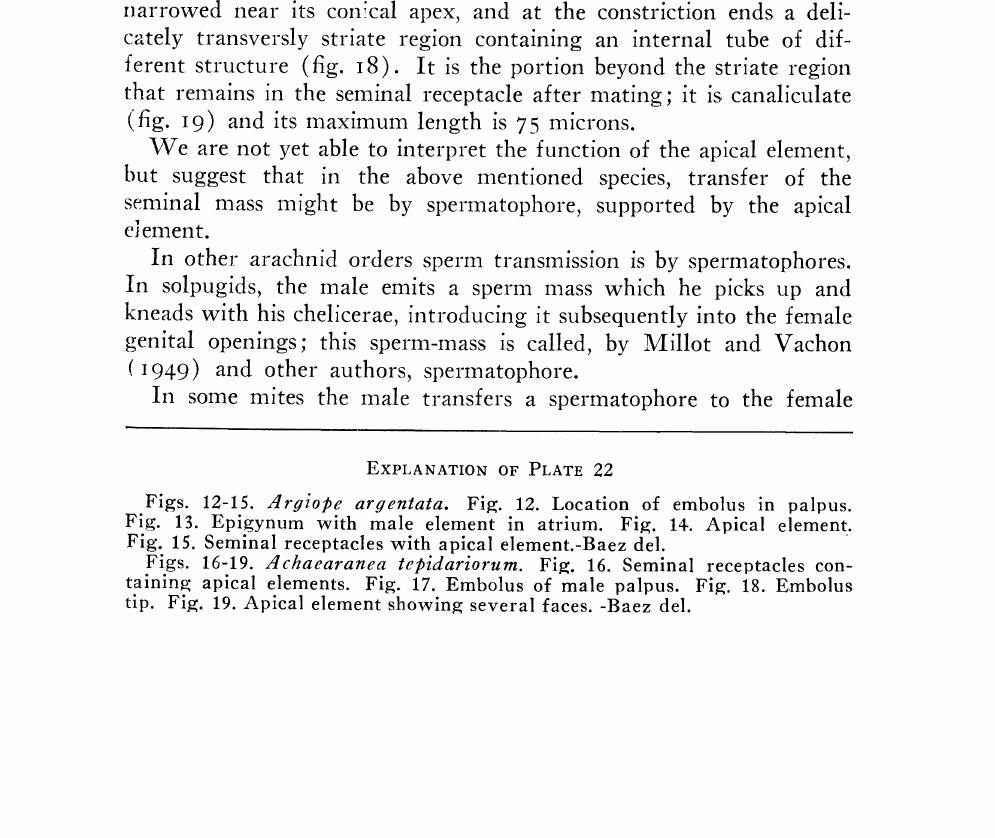
Fig. 15. Seminal receptacles with apical element.-Baez del. Figs. 16-19. Achaearanea tepidariorum. Fig. 16. Seminal receptacles eon- taininp.: apical elements. Fig. 17. Embolus of male palpus. Fig. 18. Embolus tip. Fig. 19. Apical element showing several faces. -Baez